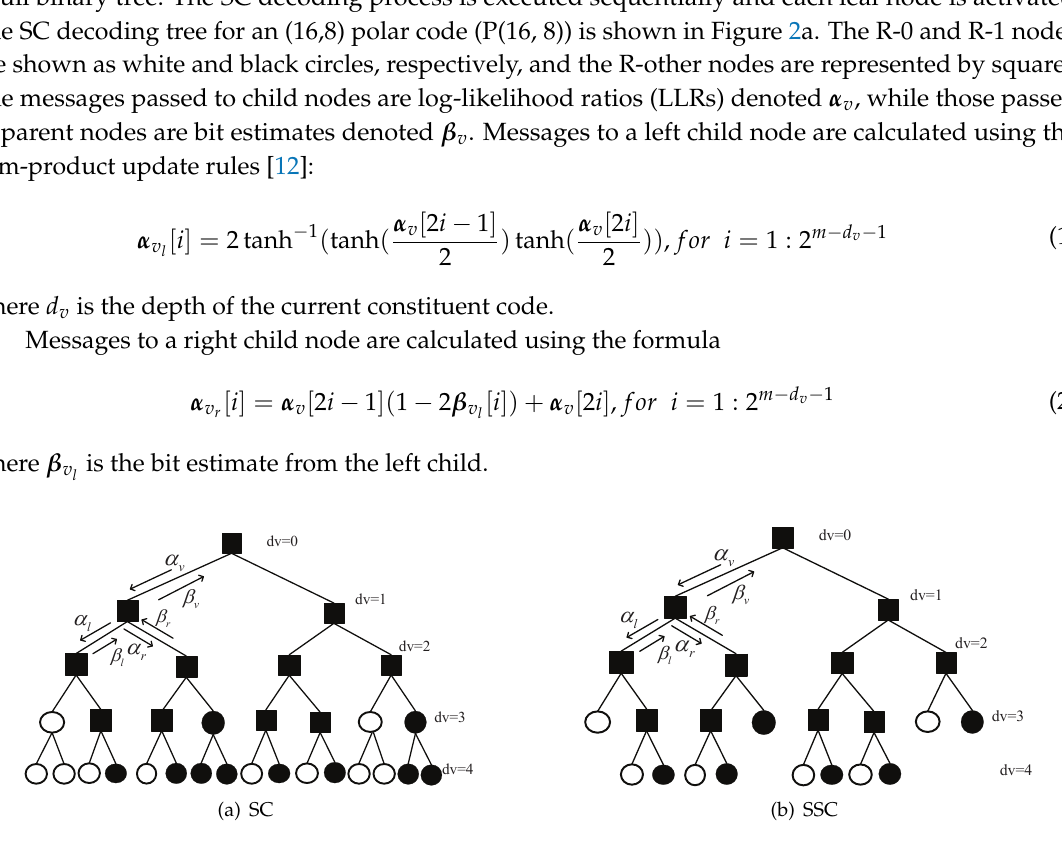
Figure 2. Decoder trees corresponding to ( a ) SC and ( b ) SSC decoding algorithms for P(16,